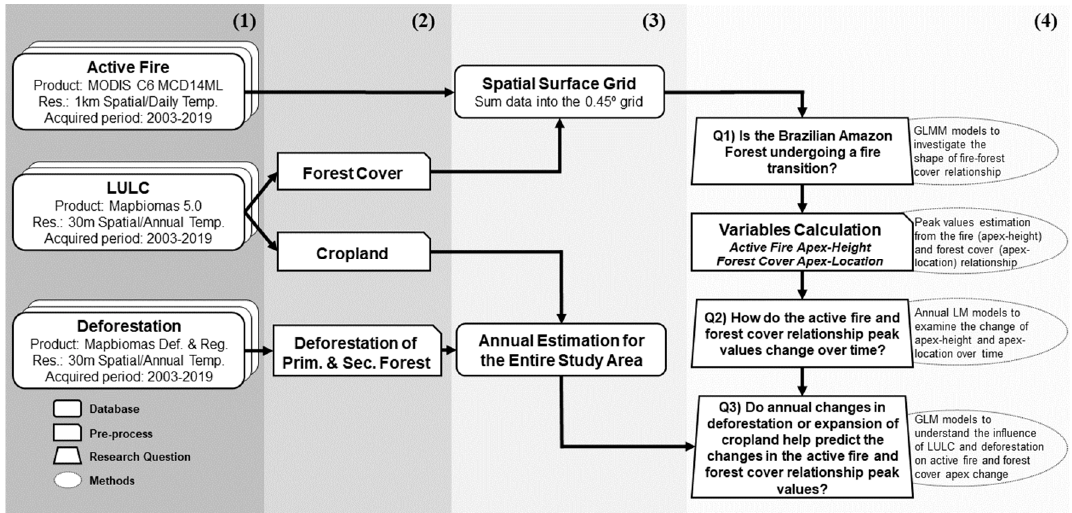
Figure 2. Workflow of the used method, describing: (1) the three main datasets to analyse and interpret the active fire behaviour in relation to forest cover: (i) Active Fire occurrence [27]; (ii) LULC [28,29]; and (iii) Annual Deforestation [25]. (2) The land cover and deforestation